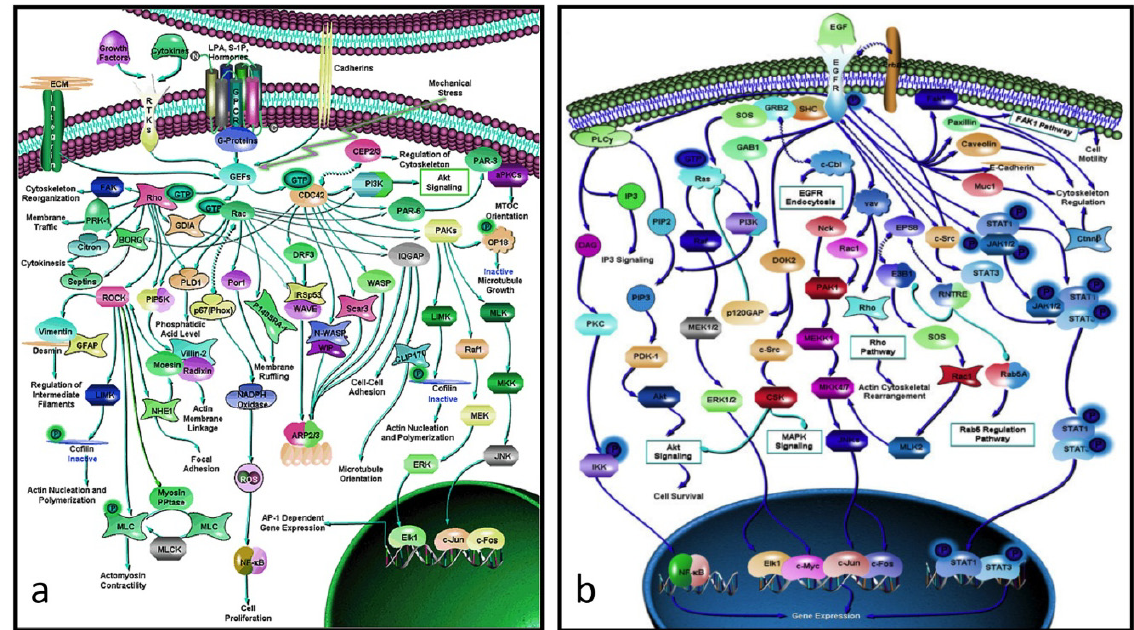
Figure 2. ( a ) Rho-GTPase network (> 70 proteins): an actin-activating network that underpins a wide range of cytoskeletal activity: movement, adhesion, microtubules, nuclear separation etc. ( b ) the EGF network (> 60 proteins) activates the cell cycle. Note that these networks are not full graphs as the details of the interactions between the proteins (the “edges”) are not specified (from